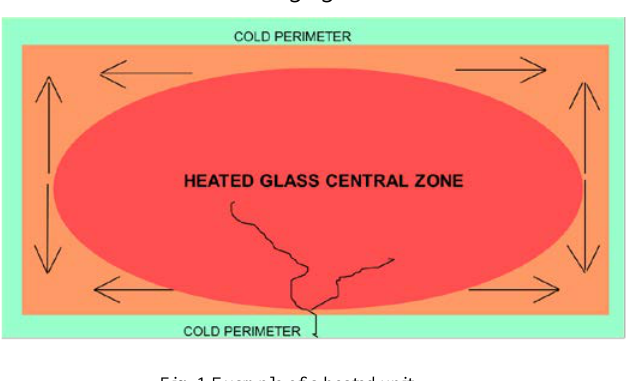
Fig. 1 Example of a heated